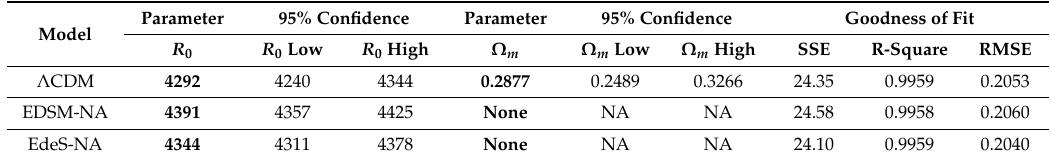
Figure 3. Evolution of inverse of scale factors and radiation density: inverse expansion scale factor 1/𝑎 𝑋 = (1 + 𝑧 𝑋 ) against the inverse standard scale factor 1/𝑎 = (1 + 𝑧) for low values ( left figure ) and high values ( middle figure ); radiation energy density scaling ( right figure ) for the nonadiabatic model EDSM-NA.